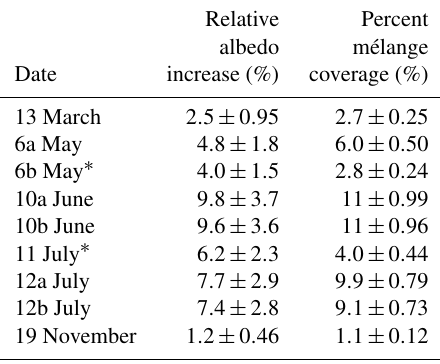
Table 4. Increase in albedo of the entire fjord surface due to the presence of ice and mélange, calculated for each scene. Both ice- bergs and mélange are taken into account for albedo calculations. Relative Percent albedo